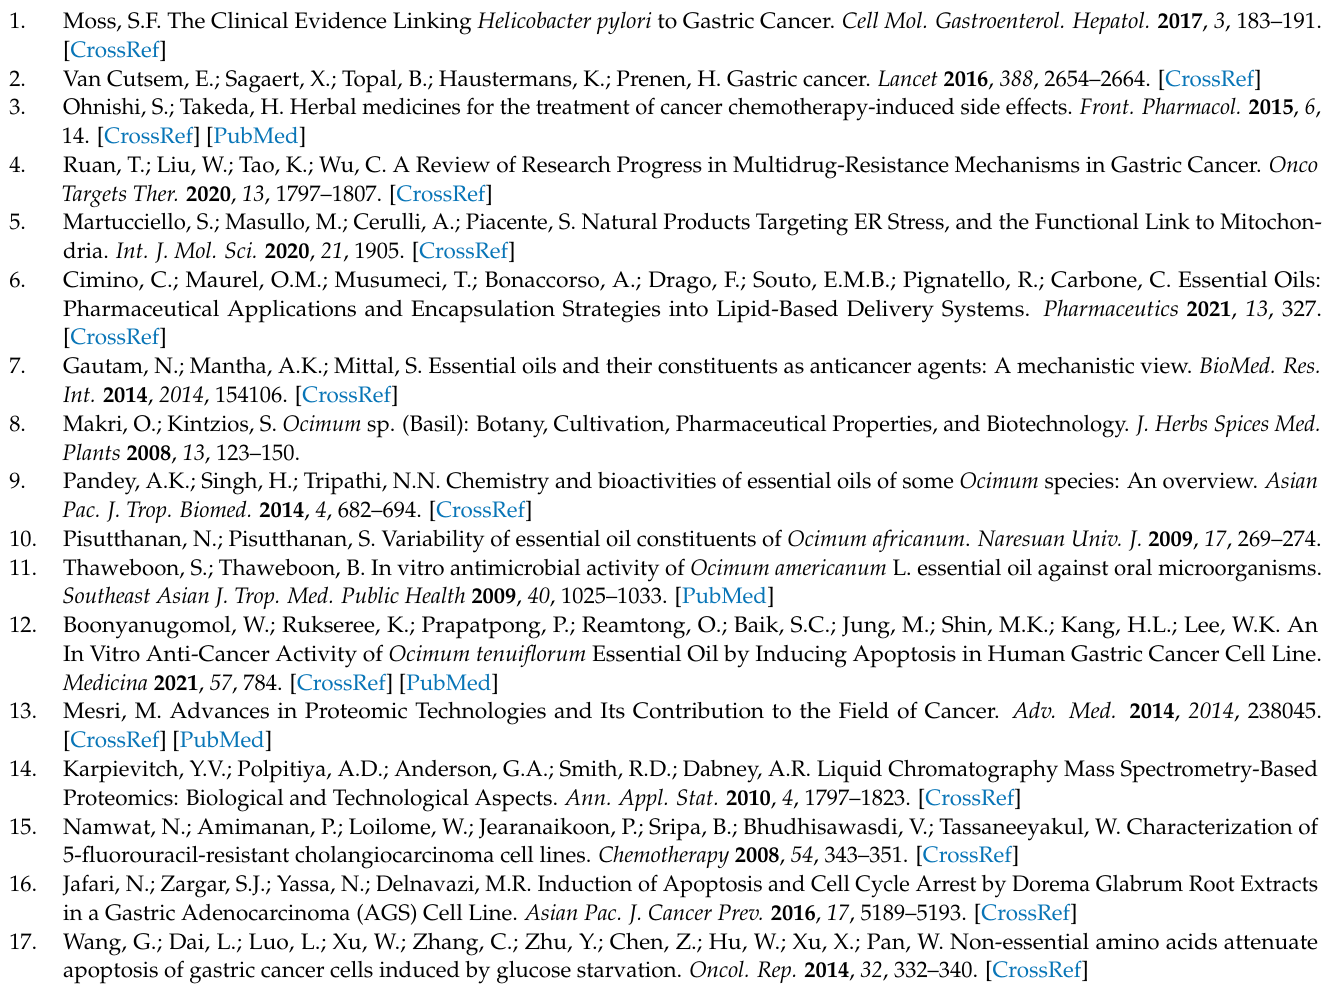
Table S1: Chemical constituents of the essential oil from O. x africanum , analyzed by GC–MS, Table S2: List of up-regulated proteins, Table S3: List of down-regulated